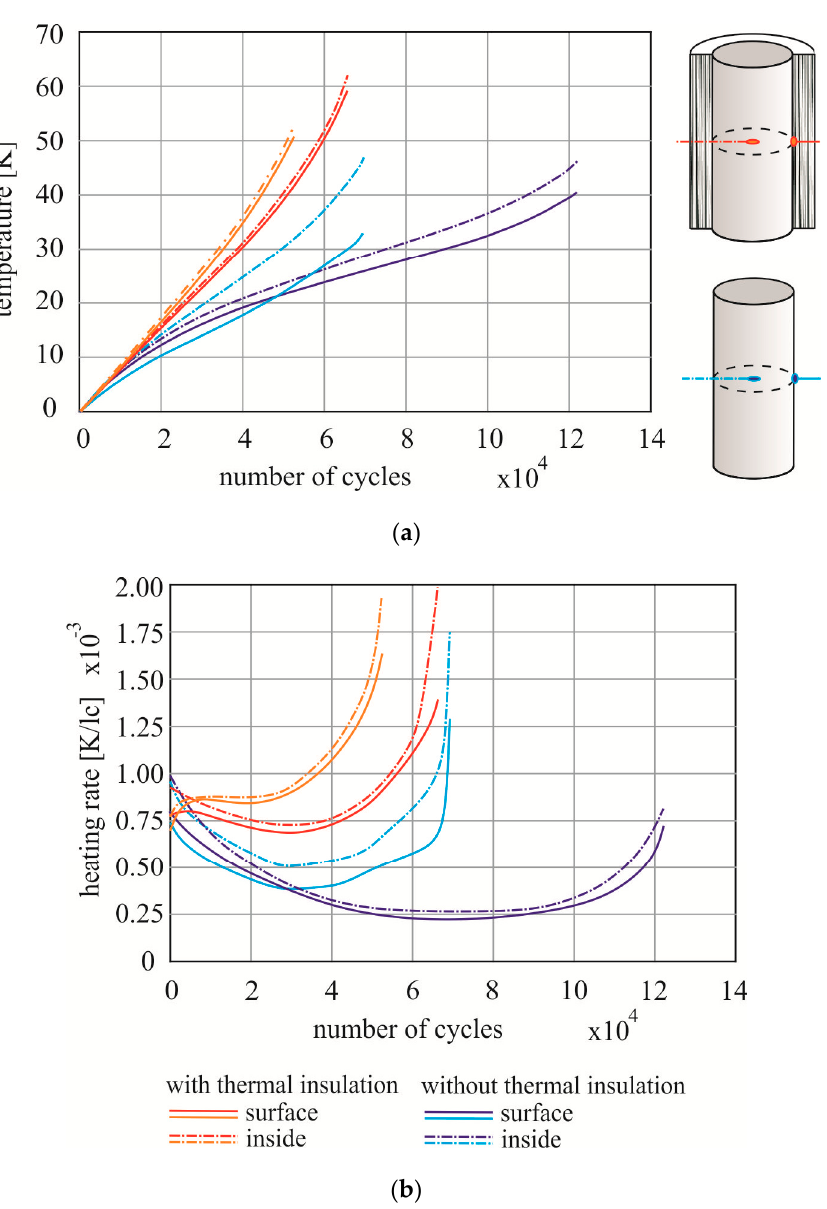
Figure 10. ( a ) Temperature development and ( b ) heating rate of test specimen with (red and orange) and without thermal insulation (purple and light blue), test conditions: frequency f P = 10 Hz, relation between lower and upper stress level S c,min /S c,max = 0.1/0.7.